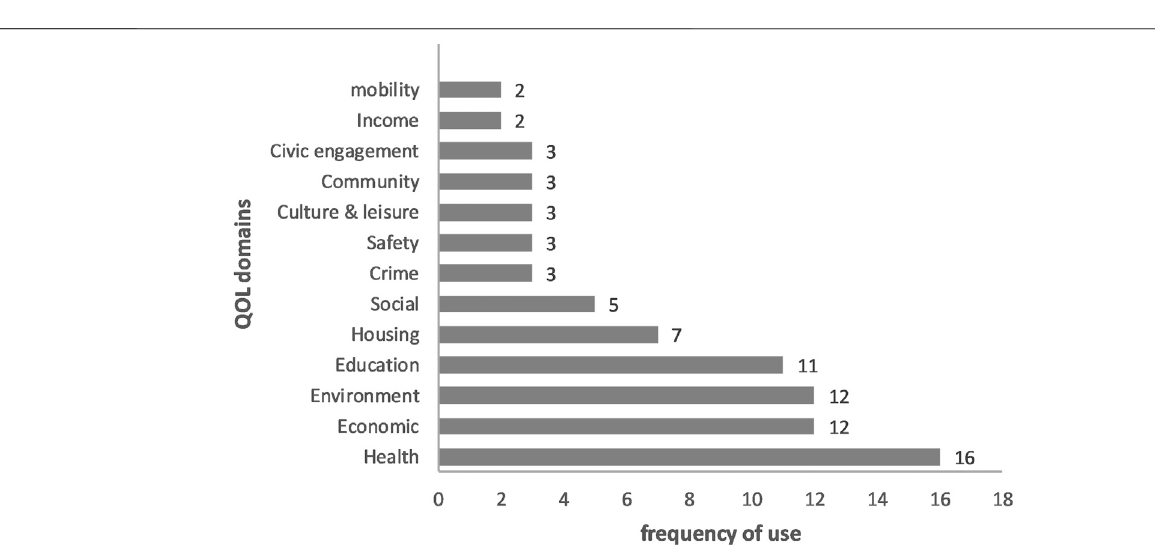
Frontiers in Built Environment |